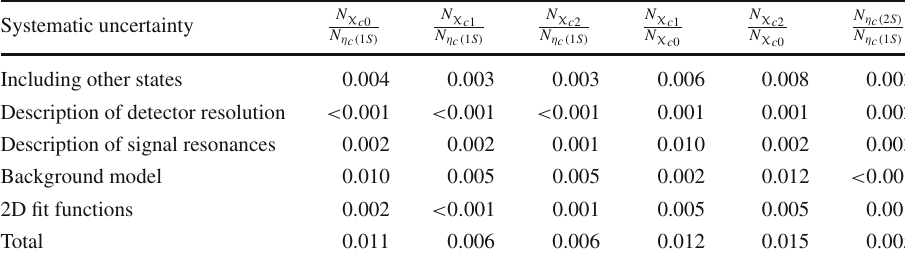
and with respect to the η c ( 1 S